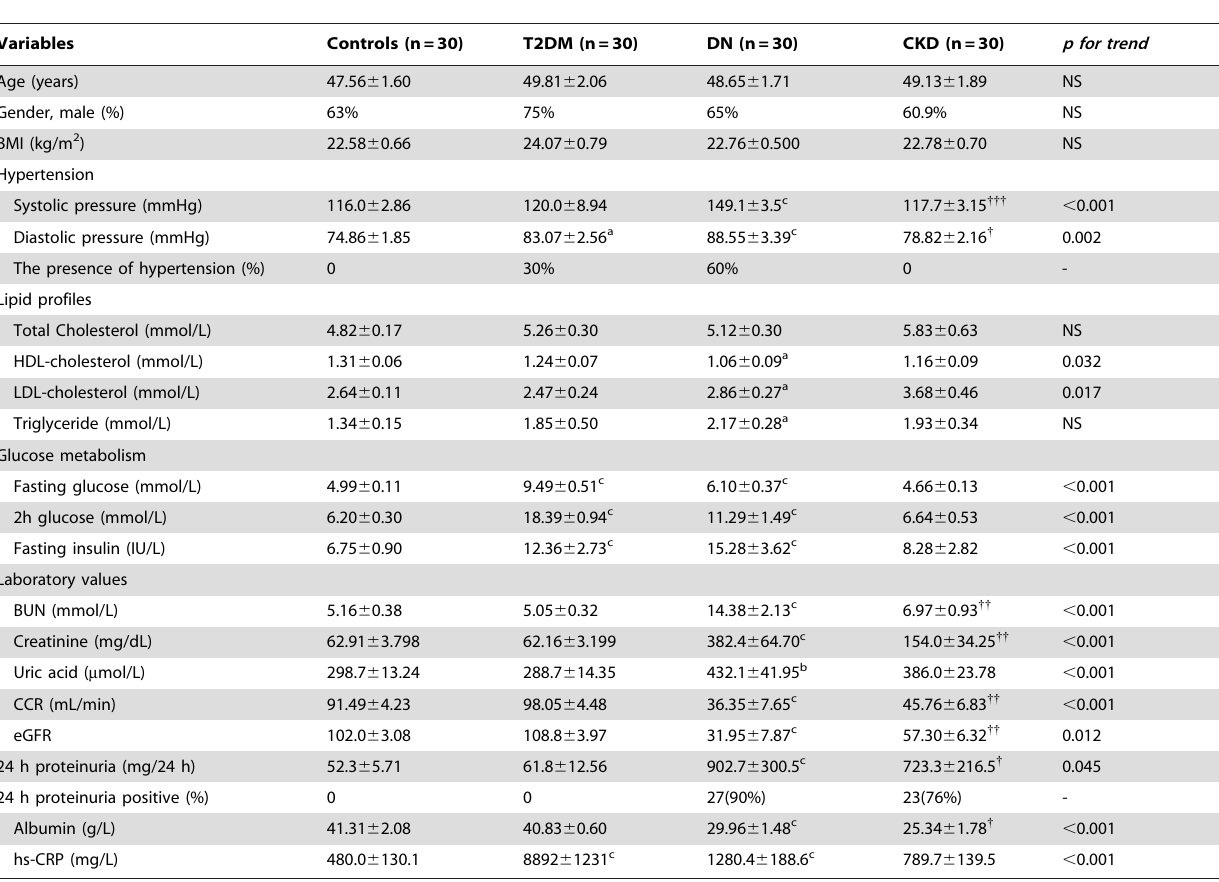
Table 1 Anthropometric parameters and biochemical index among subjects with T2DM, DN, CKD and healthy.